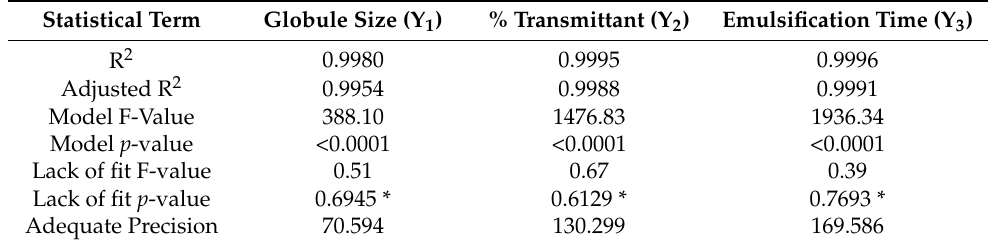
Table 3. Model statistical summary of best-fitted quadratic model of each